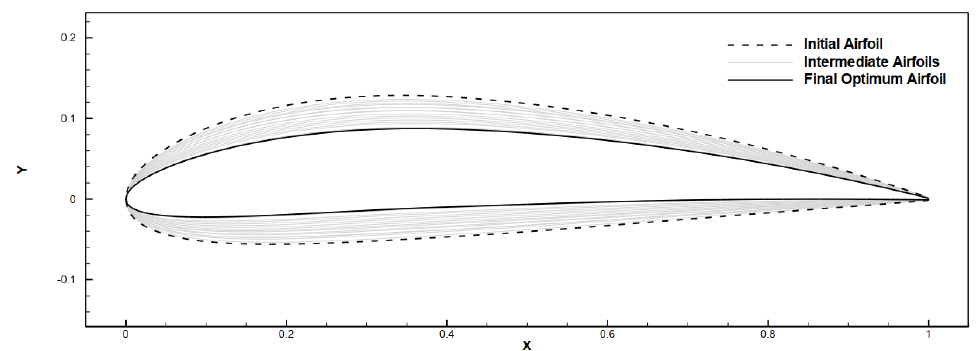
Figure 8. The proposed multipurpose optimization algorithm generated modifications in the geome- try of the airfoil